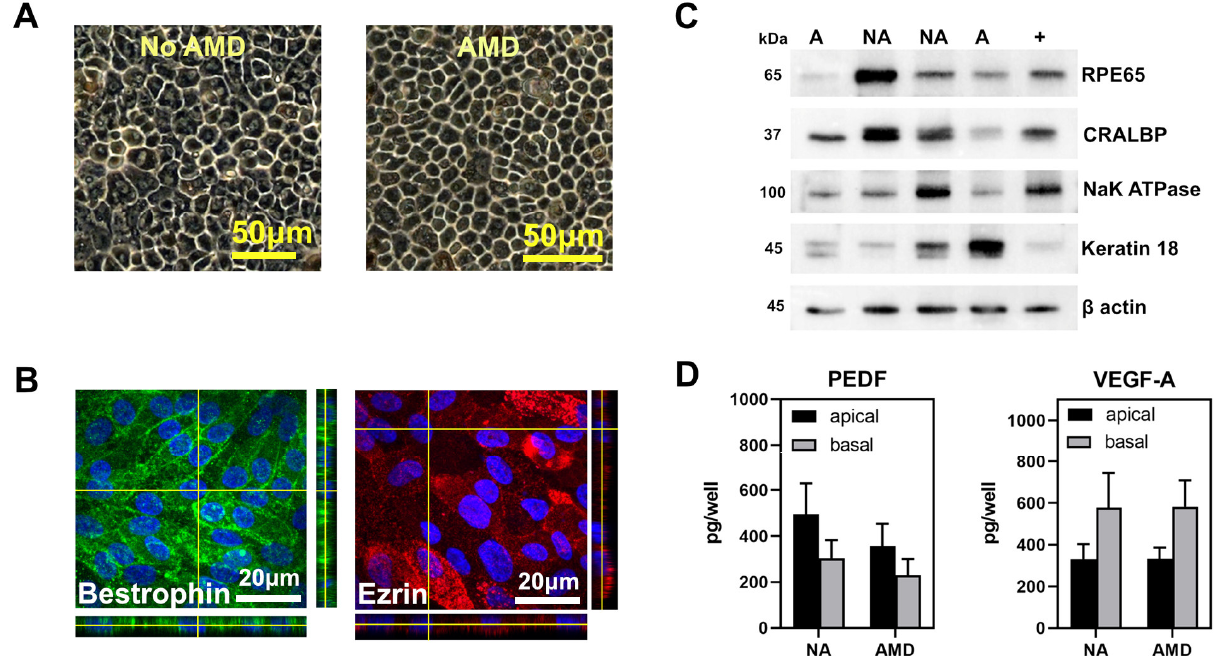
Figure 2. Characterization of haRPE cells. ( A ) Phase microscopy image showing that confluent haRPE form a monolayer with a cobblestone appearance and have pigmentation. Scale bar = 50 um. ( B ) Confocal microscopy images of haRPE. Maximal projection images and orthogonal x-z views showing Bestrophin (green) localized basolaterally and Ezrin (red) localized apically. Nuclei were stained with DAPI (blue). Scale bar = 20um. ( C ) haRPE cultures express prototypic RPE proteins, as demonstrated by Western blots. Molecular mass for each protein is shown on the left. NA = No AMD, A = AMD. (+) is a homogenate of RPE tissue from a human donor. β -Actin is loading control. ( D ) Results from ELISA analysis of pigment epithelium-derived factor (PEDF) and vascular endothelial growth factor A (VEGF-A) content measured in apical and basal media from haRPE grown on transwells.